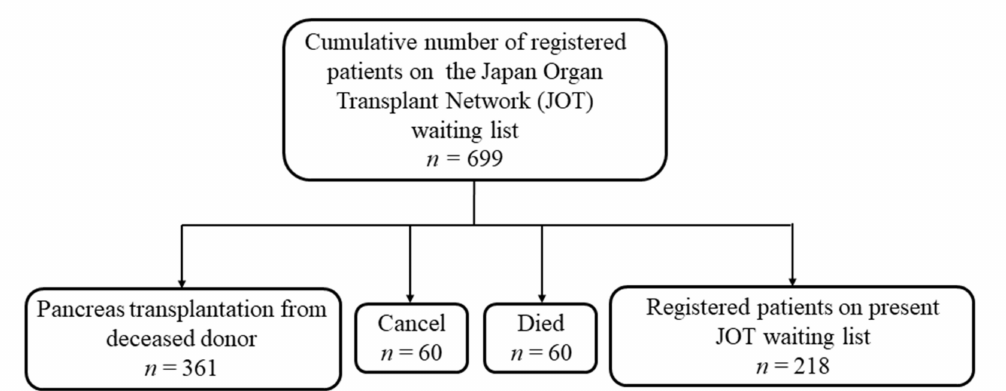
Figure 1. Schematic illustration of the present study. The prognosis of patients on the waiting list of the Japan Organ Transplant Network. Among the 699 waiting patients, 361 patients received pancreas transplantation. Sixty patients died and 60 cases were removed from the waiting list. As of 31 August 2019, 218 cases were still registered on the waiting list for pancreas transplantation.